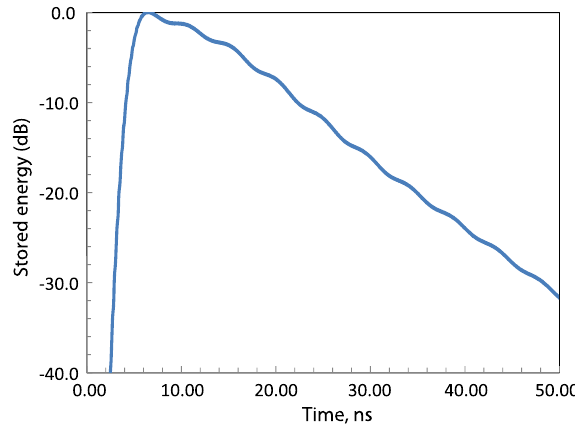
FIG. 10 (color online). The decay of electromagnetic energy through the waveguides of a PBG resonator shown in Fig.